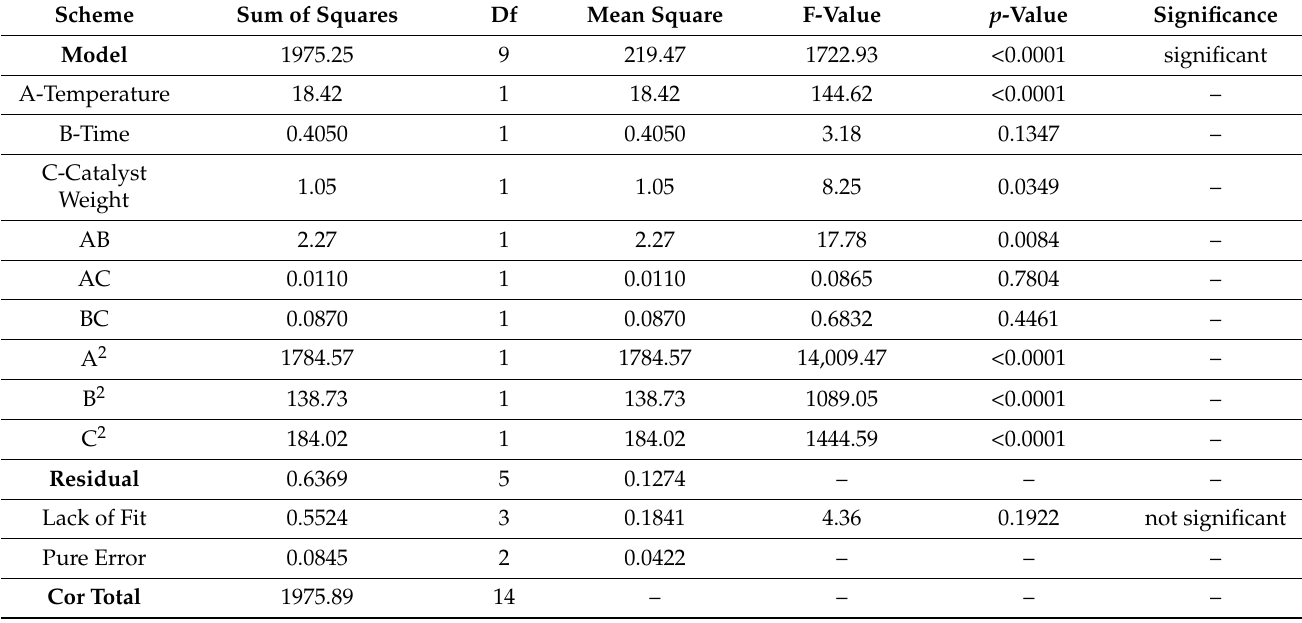
Table 6. ANOVA of Box–Behnken design for the dependent variable (carbon yield) in terms of independent variables (different process